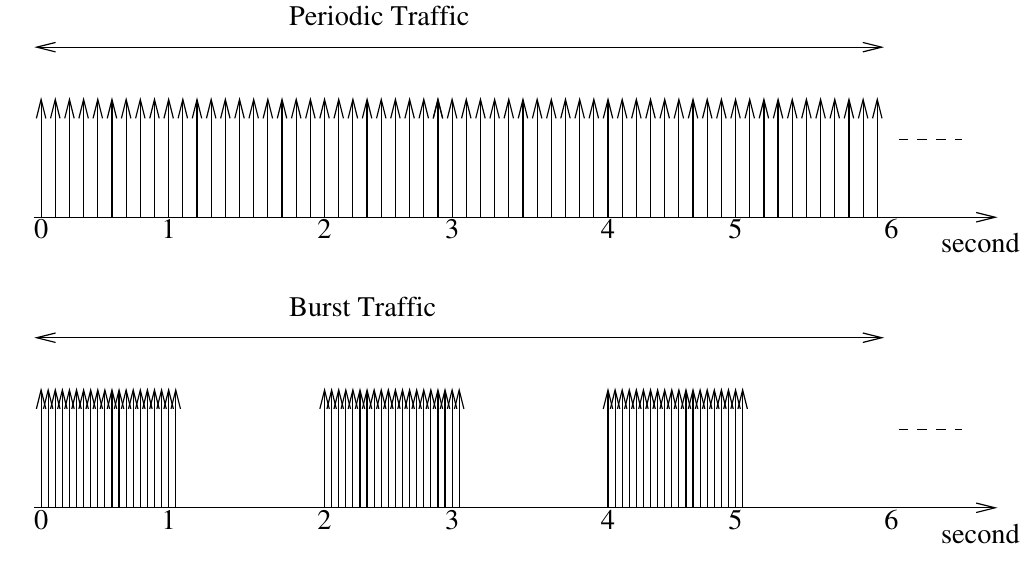
Figure 6. Traffic generation in periodic and burst